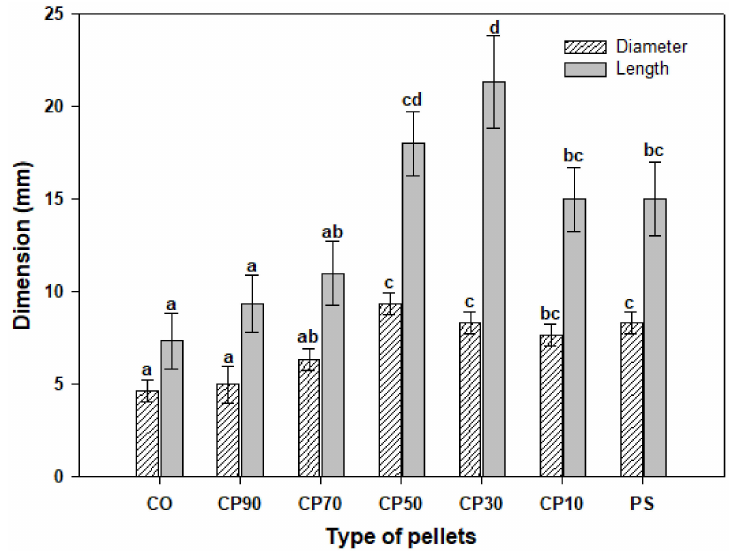
Figure 2. Pellet size according to SCG blending ratio. Each point is the mean of three repeated measurements and is the mean ± standard deviation. The means with different letters (a–d) above the bars indicate significant differences based on Tukey’s honest significant difference (HSD) test ( p < 0.05).